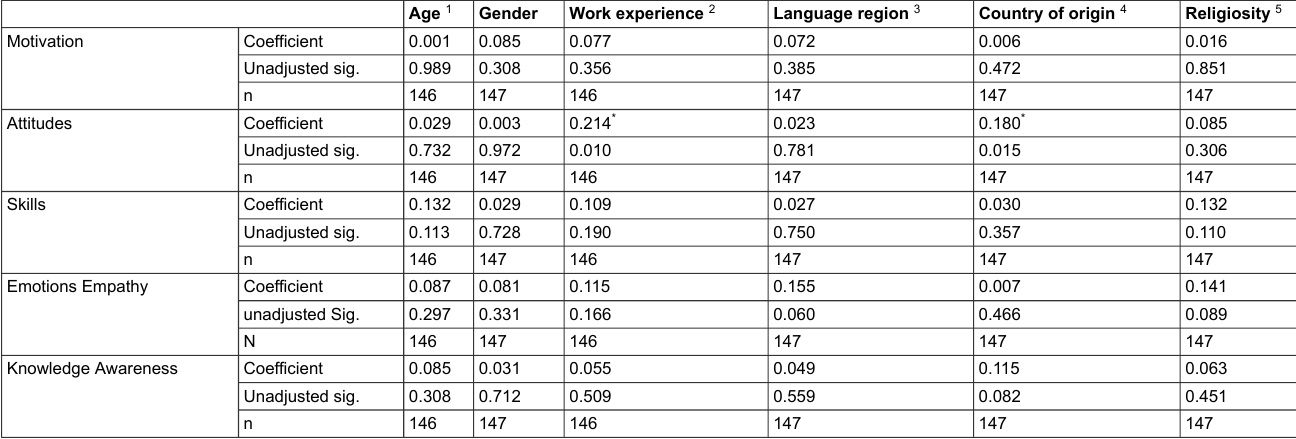
Table S1: Exploratory correlation analyses (Pearson, Spearman, point-biserial